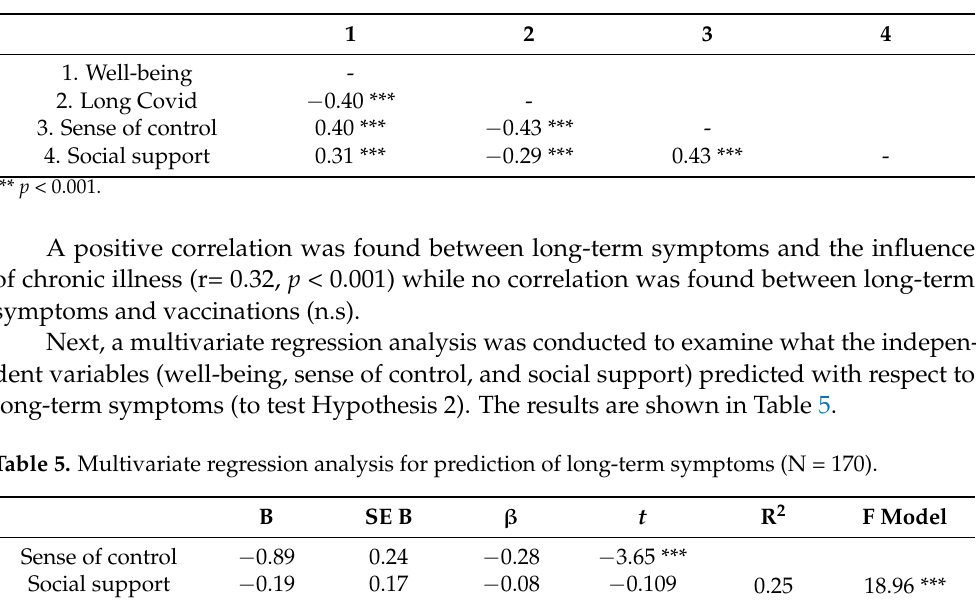
Table 4. Correlations between the study variables (N = 170).